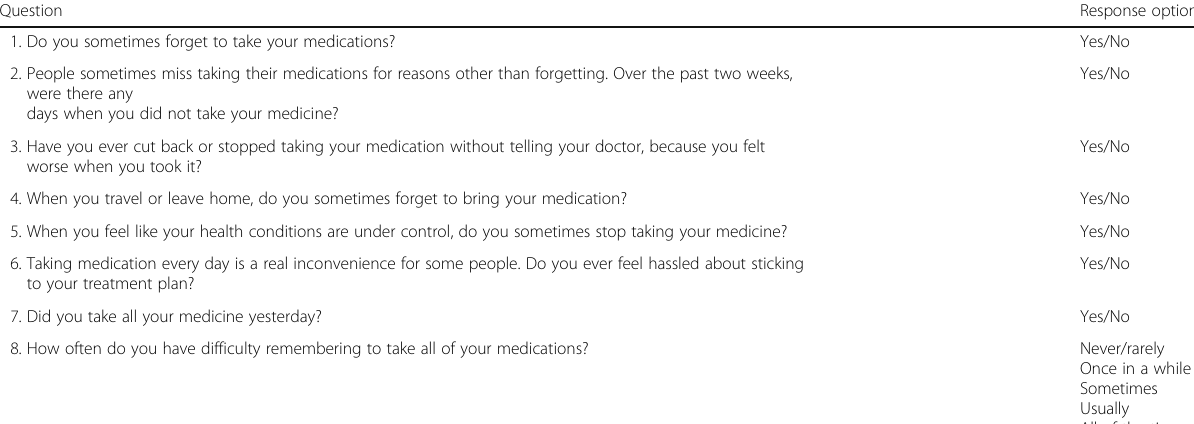
Table 6 Morisky Medication Adherence